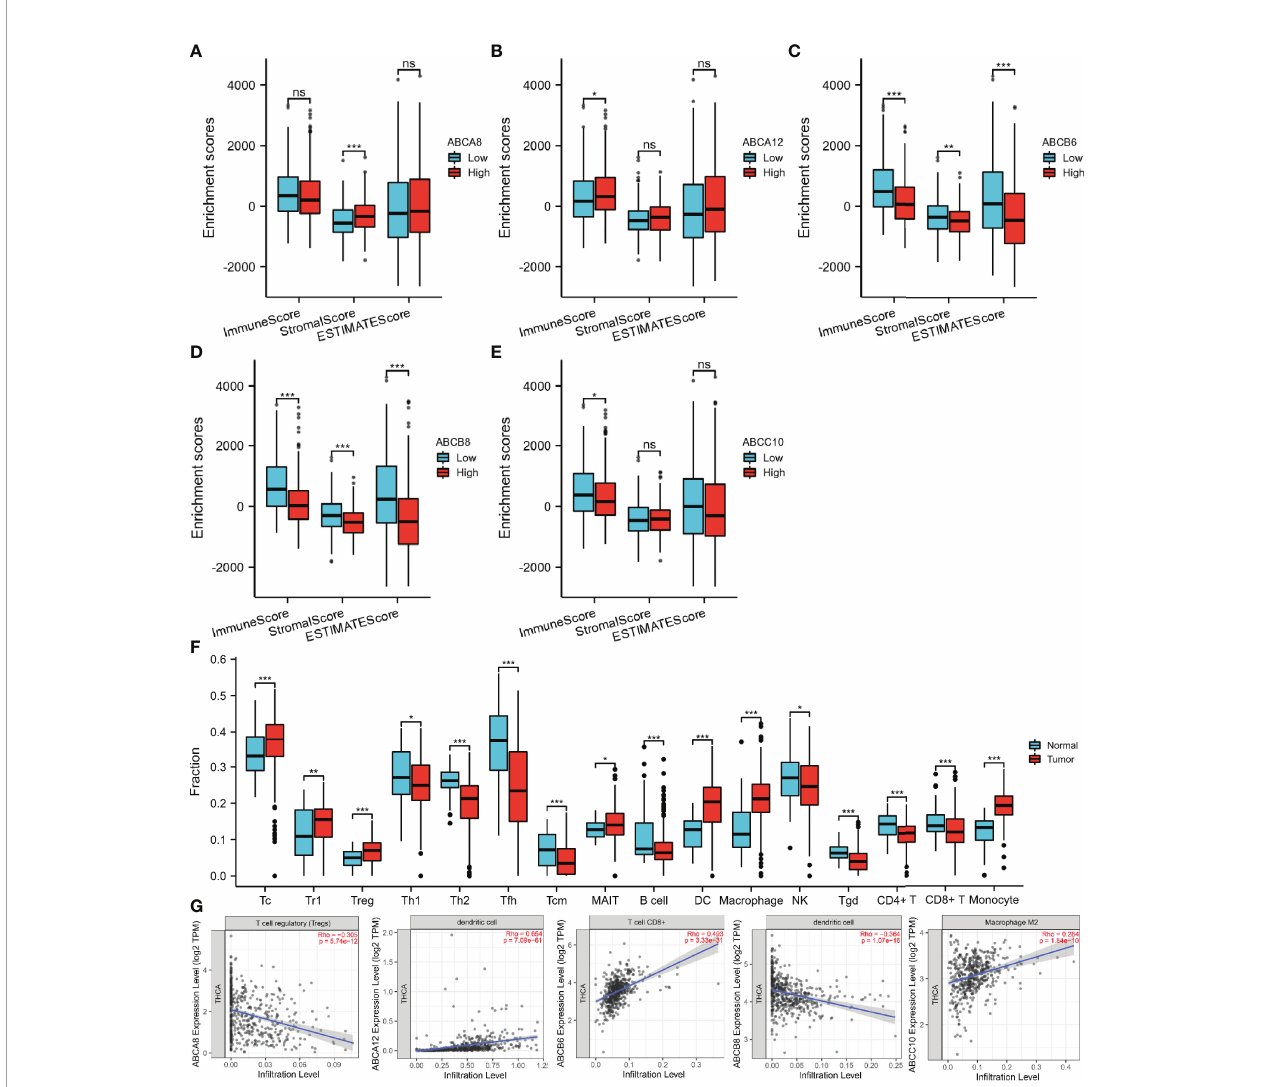
FIGURE 2 | Immune-associated analysis of the hallmark ABC transporters in TC. (A – E) Correlation between the expression levels of hallmark ABC transporters and immune, stromal, and ESTIMATE scores. (F) Differential abundances of tumor-in fi ltrating immune cells between TC and normal thyroid tissues. (G) Correlation between the expression levels of hallmark ABC transporters and the abundances of tumor-in fi ltrating immune cells, which were most associated with each hallmark ABC transporters. * P < 0.05, ** P < 0.01, *** P < 0.001. ns, not signi fi